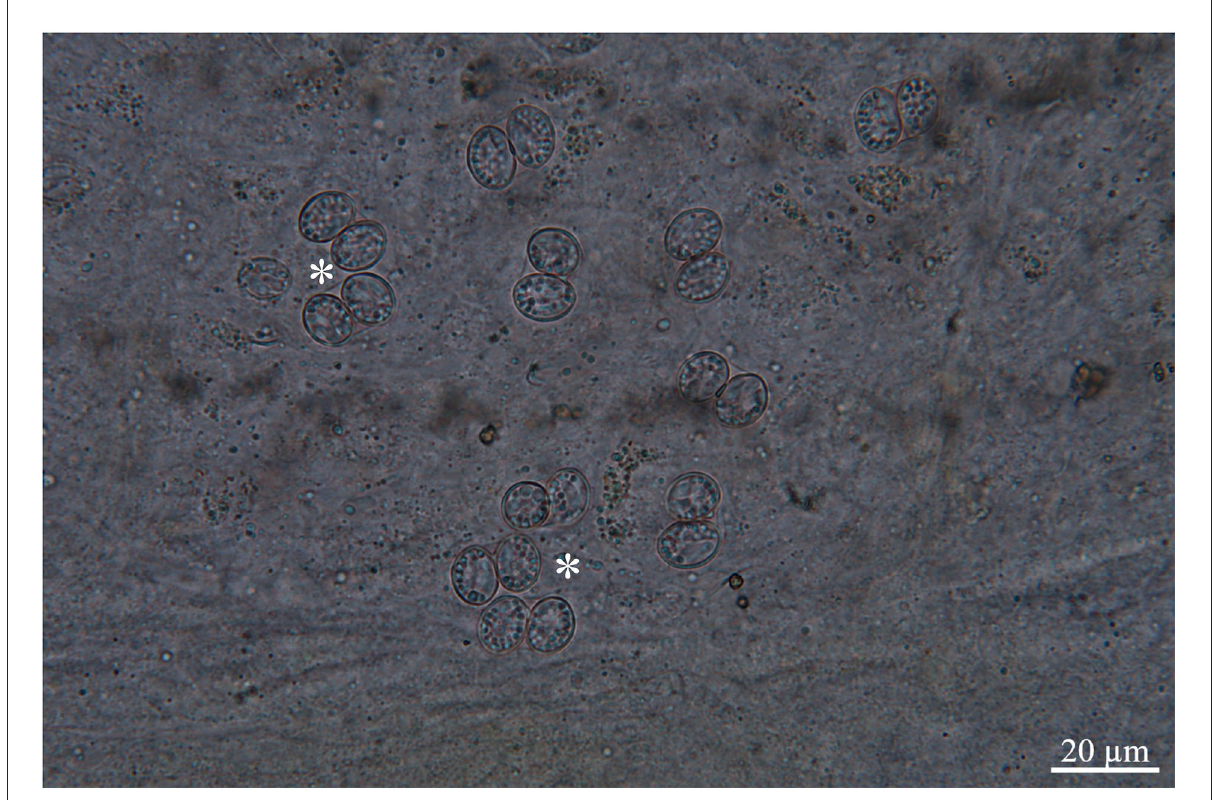
FIGURE1 Scraping of intestinal mucosa, asterisks showing oocysts, ligth micrcosocpy.